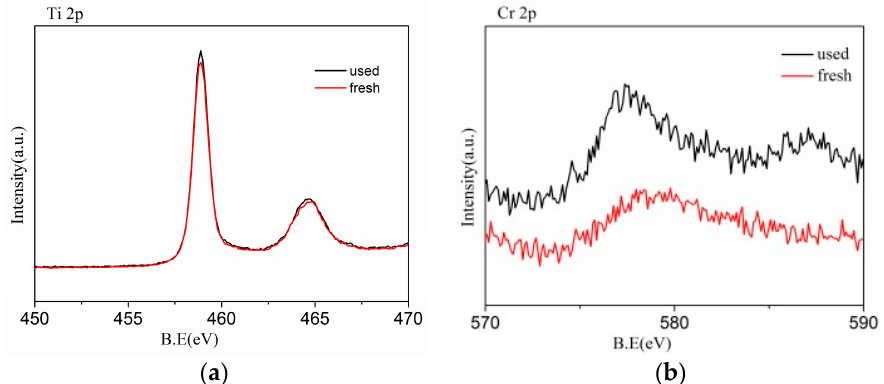
Figure 13. XPS survey spectra of fresh RCP-AG(15) and the used RCP-AG ( a ) Ti 2p, ( b ) Cr 2p.